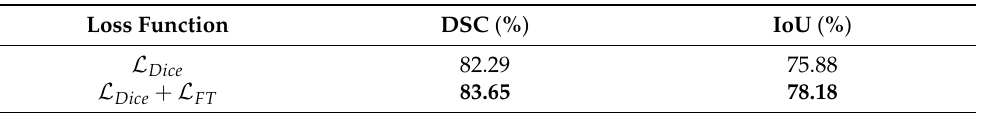
Table 4. Quantitative comparison results of different loss functions in terms of dice similarity coefficients (DSC) and intersection over union (IoU).